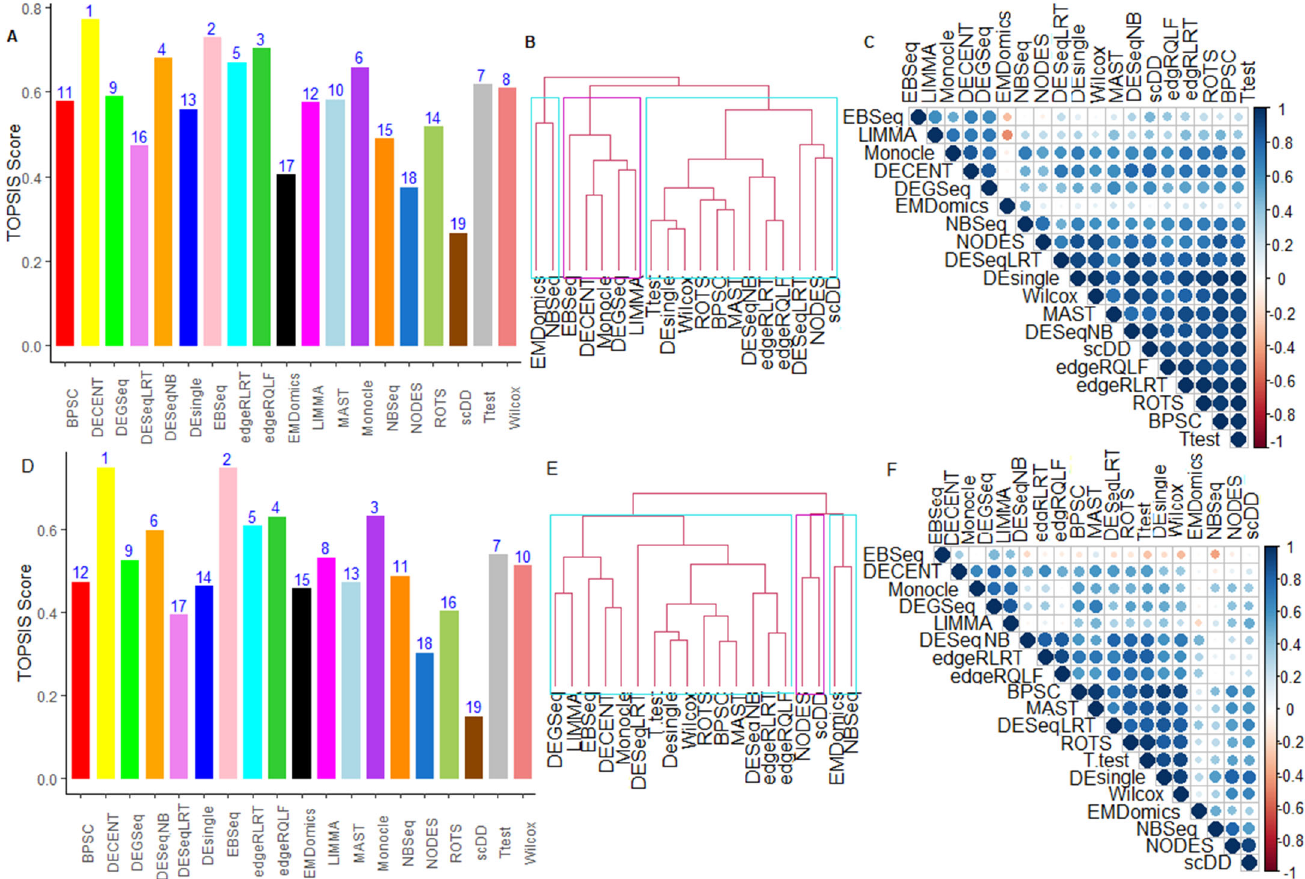
Figure 5. Combined data analysis of methods based on FDR and Accuracy metrics through TOPSIS technique. Comparative performance evaluation of DE methods was performed based on FDR and Accuracy metrics through TOPSIS technique under multi-data setup. This analysis was performed on the matrix having FDR and Accuracy scores of tested methods across 11 considered datasets. ( A ) TOPSIS analysis of tested methods based on FDR across real datasets. Bars show values of TOPSIS scores and number on each bar represents ranks; ( B ) Similarity analysis of methods based on FDR through clustering. Dendrogram was obtained by average-linkage hierarchical clustering based on the matrix of average FDR scores across all datasets. ( C ) Similarity analysis of methods based on FDR through correlation. Correlation plot was obtained by Spearman’s rank correlation method. White color boxes show non-significant correlation; ( D ) TOPSIS analysis of methods based on Accuracy across the real datasets. Bars show values of TOPSIS scores and number on each bar represent methods’ ranks; ( E ) Similarity analysis of methods based on Accuracy through clustering. ( F ) Similarity analysis of methods based on Accuracy metrics through correlation. Correlation plot was obtained by Spearman’s rank correlation for Accuracy scores across all datasets. Strength of correlation is shown through color intensity.